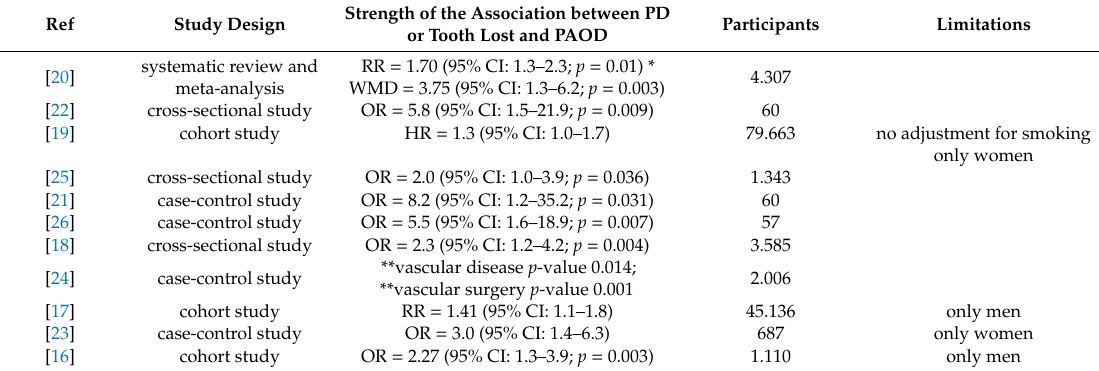
Table 1. Summary of the strength of the association between PD or tooth loss and PAOD. RR = risk ratio; OR = odds ratio; HR = hazard ratio; WMD = weighted mean di ff erence. * PAOD patients had more missing teeth than non-PAOD participants. ** conditions that were significantly related to bone loss or number of missing